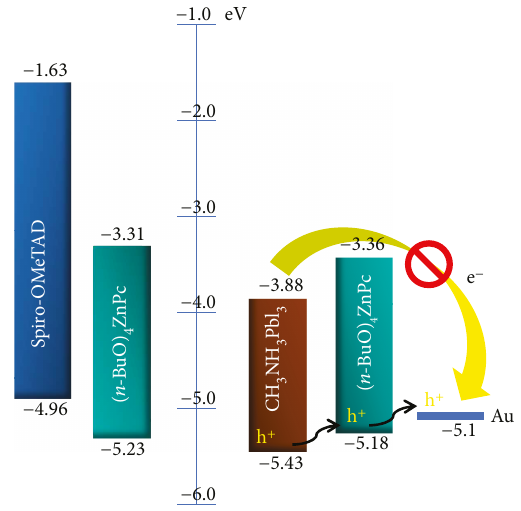
Figure 4: Left side: theoretically estimated reduction potentials of ( n -BuO) ZnPc and Spiro-OMeTAD. Right side: energetic 4 positioning of ( n -BuO) ZnPc within a 4